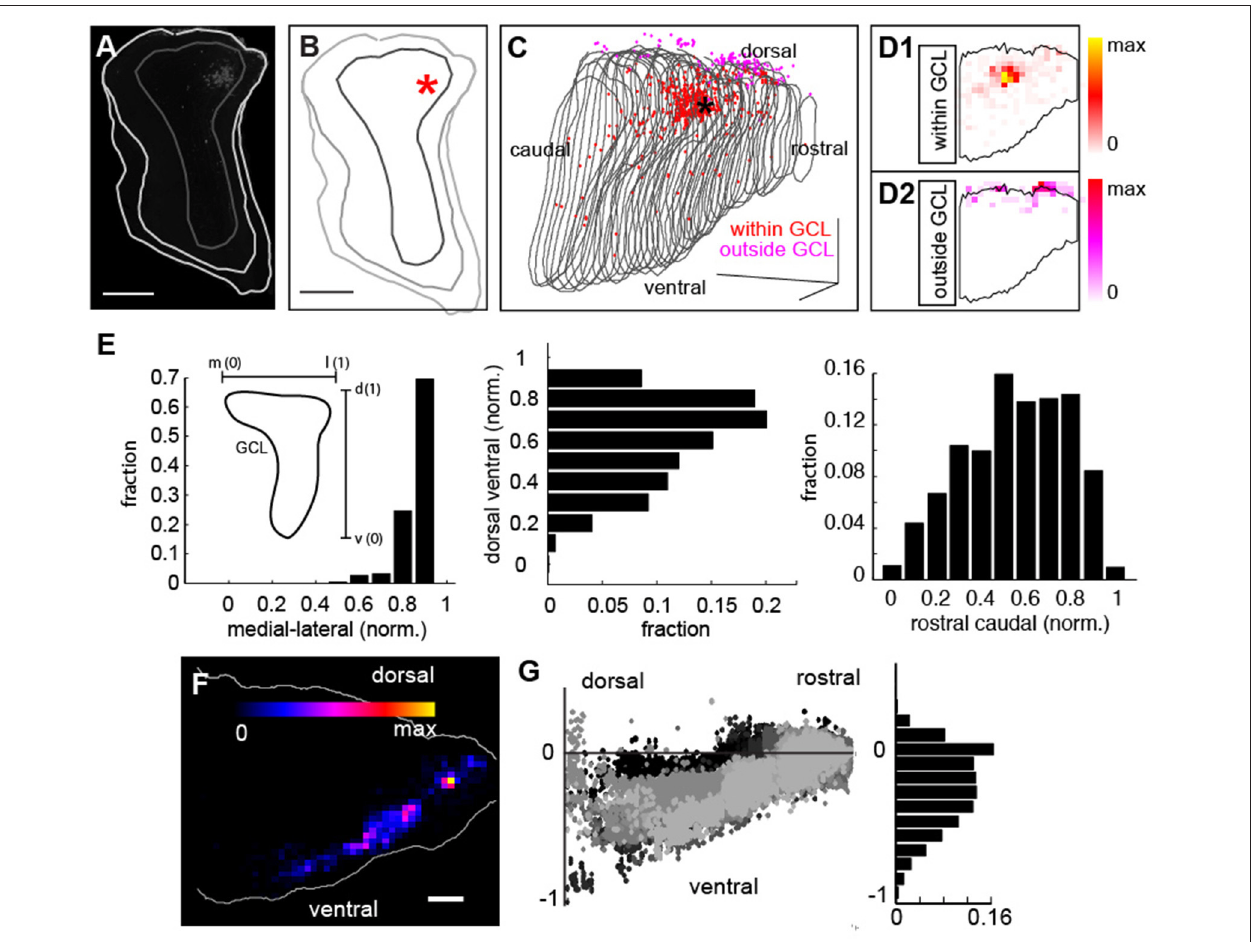
FIGURE 4 | Distribution of injection sites and retrograde label throughout the mouse brain. (A) Coronal section of injection site with GCL border in dark gray and tissue border in light gray. Scale bar = 500 um. (B) Reconstruction of coronal section in (B) with injection site in asterisk. Scale bar = 500 um. (C) 3D reconstruction of GCL (gray lines correspond to each coronal section) viewed from a sagittal perspective within neurons at the injection site within the GCL in red and fluorescently labeled neurons outside the GCL in magenta. Scale bar = 500 um. (D1) Density of neurons at the injection site within the GCL (black outline) and (D2) density of neurons outside the injection site (black outline) but within the bulb. (E) Distribution of labeled neurons in the GCL for all experiments along the medial-lateral axis (left), and the dorsal-ventral axis (middle) and the rostral-caudal axis (right). The insert in (E) shows that the skew in the distribution is due to the skew in the morphology of the GCL. (F) Dorsal ventral density distribution of labeled neurons from 1 example experiment. (G) Dorsal-ventral scatter (normalized to injection site) for 10 experiments, (left) reveals that retrograde labeled cells are confined largely to the ventral regions of the mouse brain (right) corresponding to regions who trace their origins to